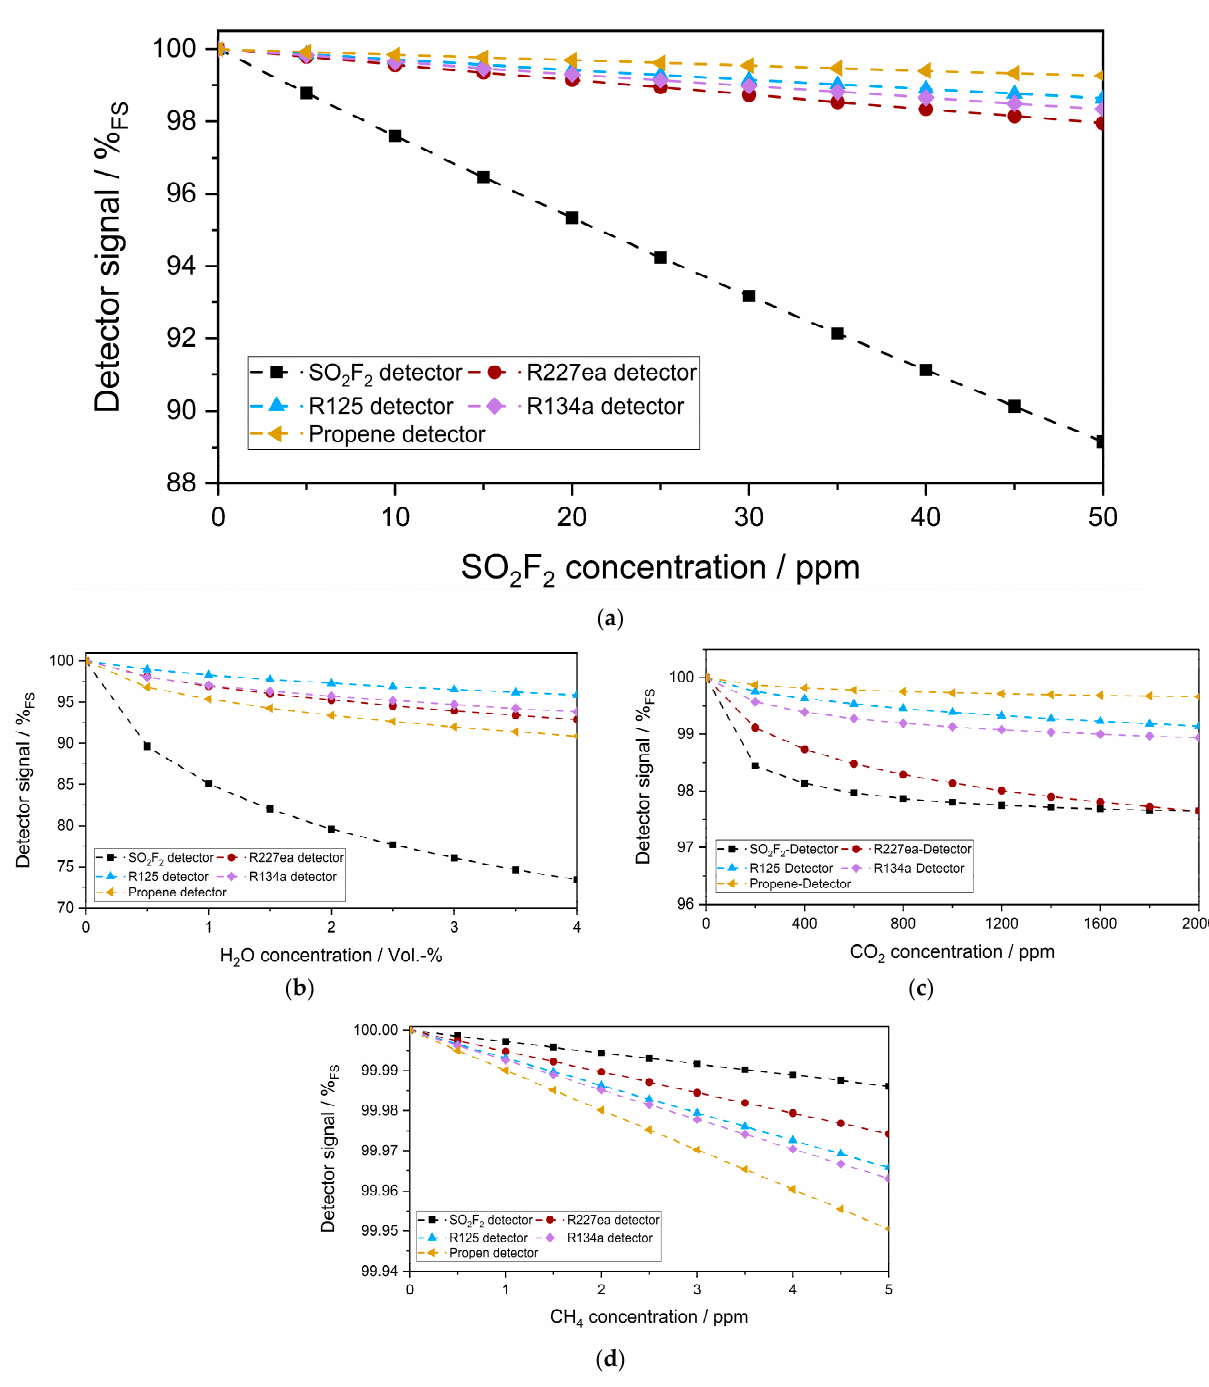
Figure 8. ( a ) Simulated sensitivity of the photoacoustic detectors to 0–50 ppm SO 2 F 2 in the absorp- tion cell (1.6 m) and the cross-sensitivity to ambient H 2 O (0–4 Vol.-%) ( b ) ambient CO 2 (0–2,000 ppm) ( c ) and ambient CH 4 (0–5 ppm) ( d ). ( c ) and ambient CH 4 (0–5 ppm) ( d